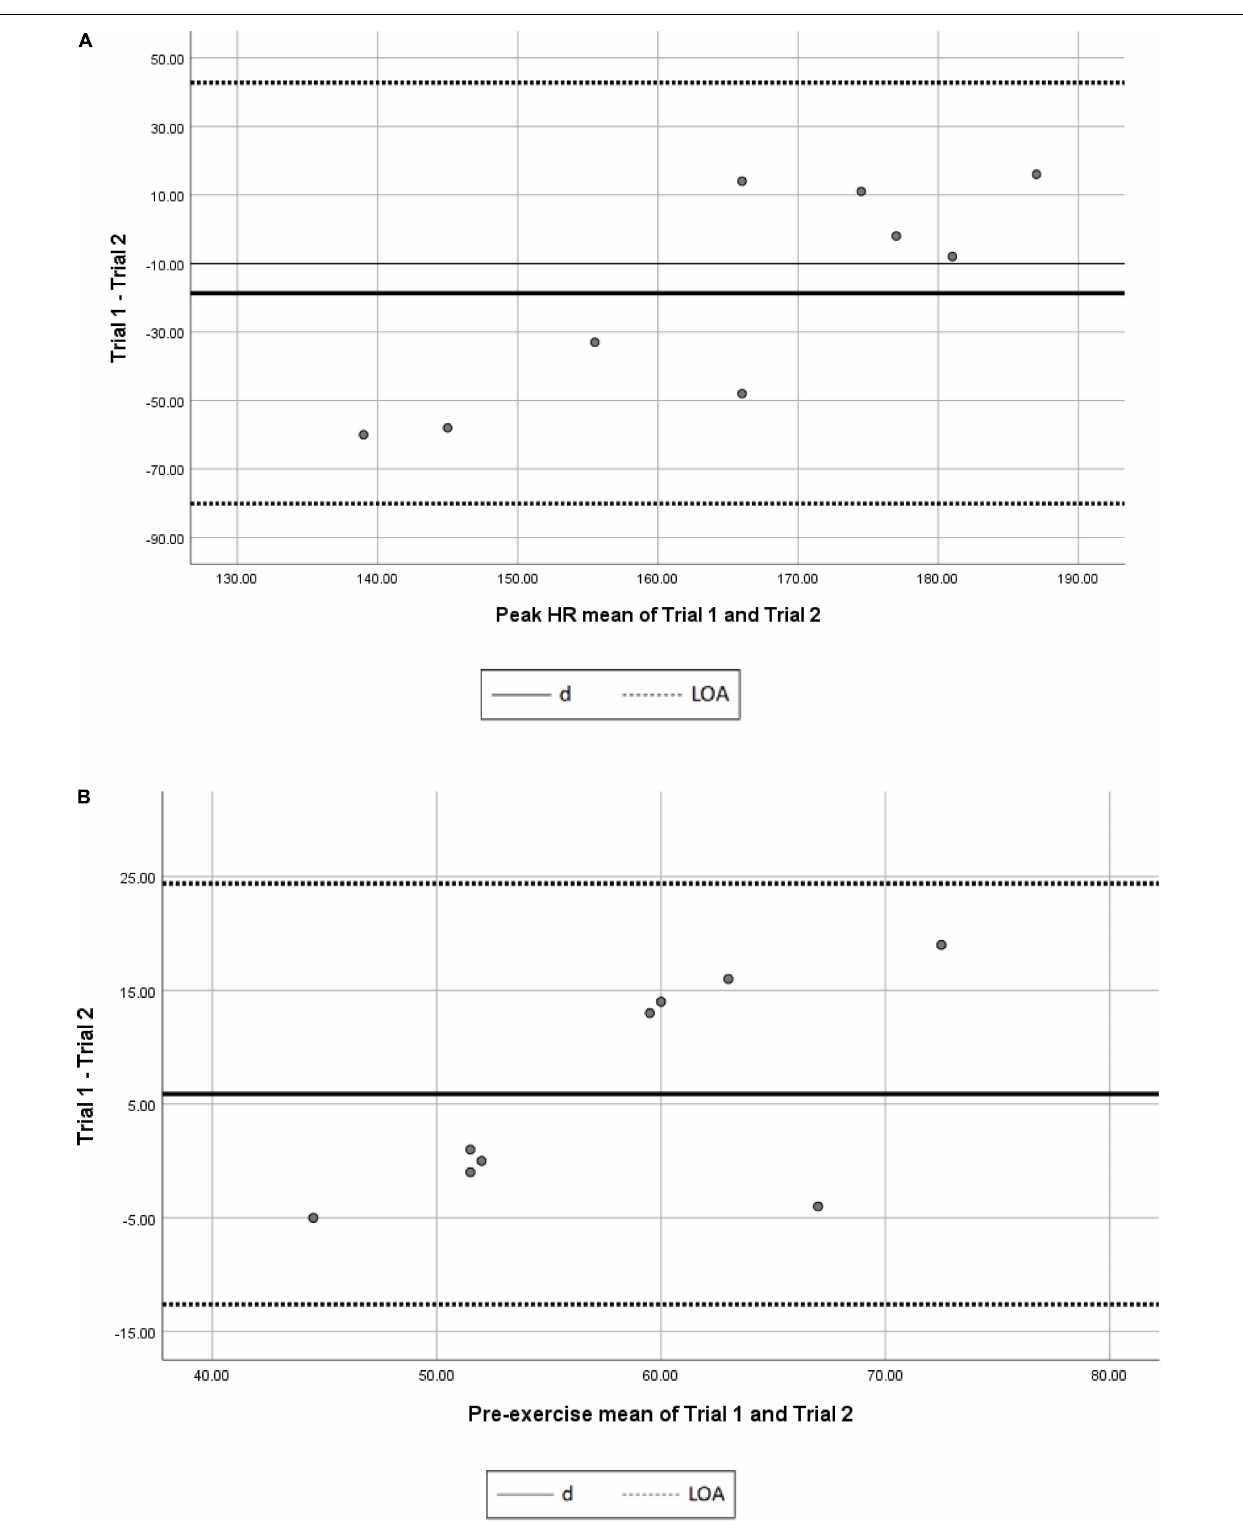
FIGURE 2 | (A) Bland-Altman plot reliability of Hexoskin in measuring peak HR. d, mean difference between peak HR trial 1 and 2; LOA, limits of agreement; HR, heart rate (batt/min). (B) Bland-Altman plot reliability of Hexoskin in measuring pre-exercise HR. d, mean difference between pre-exercise HR trial 1 and 2; LOA, limits of agreement; HR, heart rate